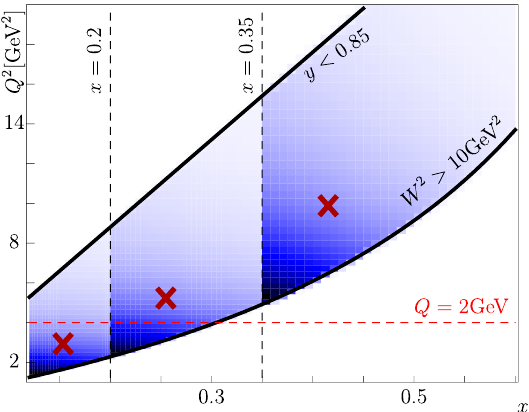
Figure 4 . Illustration for bin shapes in HERMES kinematics. Three bins are shown (0 : 12 < x < 0 : 2, 0 : 2 < x < 0 : 35, 0 : 35 < x < 0 : 6). Solid lines are boundaries of the (cid:12)ducial region. Color density demonstrates the distribution of multiplicity value within a bin. Crosses show the averaged ( x; Q ) over multiplicities in a bin. The bin 0 : 12 < x < 0 : 2 is not included in the (cid:12)t since it has h Q i <